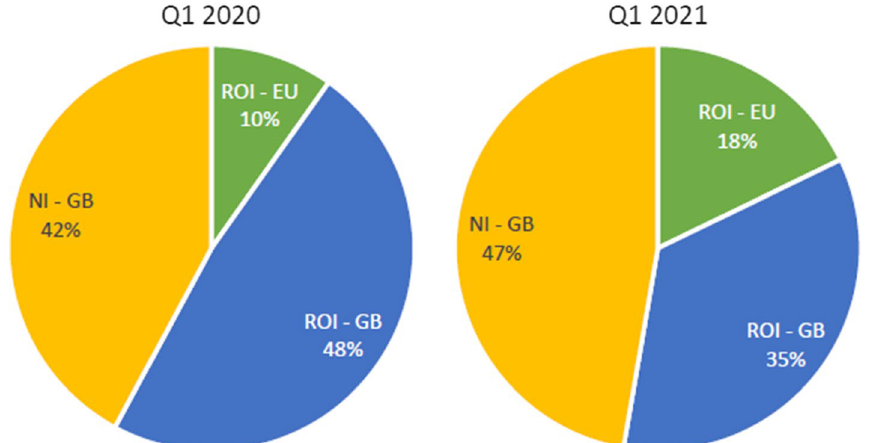
Fig. 3 Shifting Traffic Patterns between Q1 2020 to Q1 2021. Source (IMDO